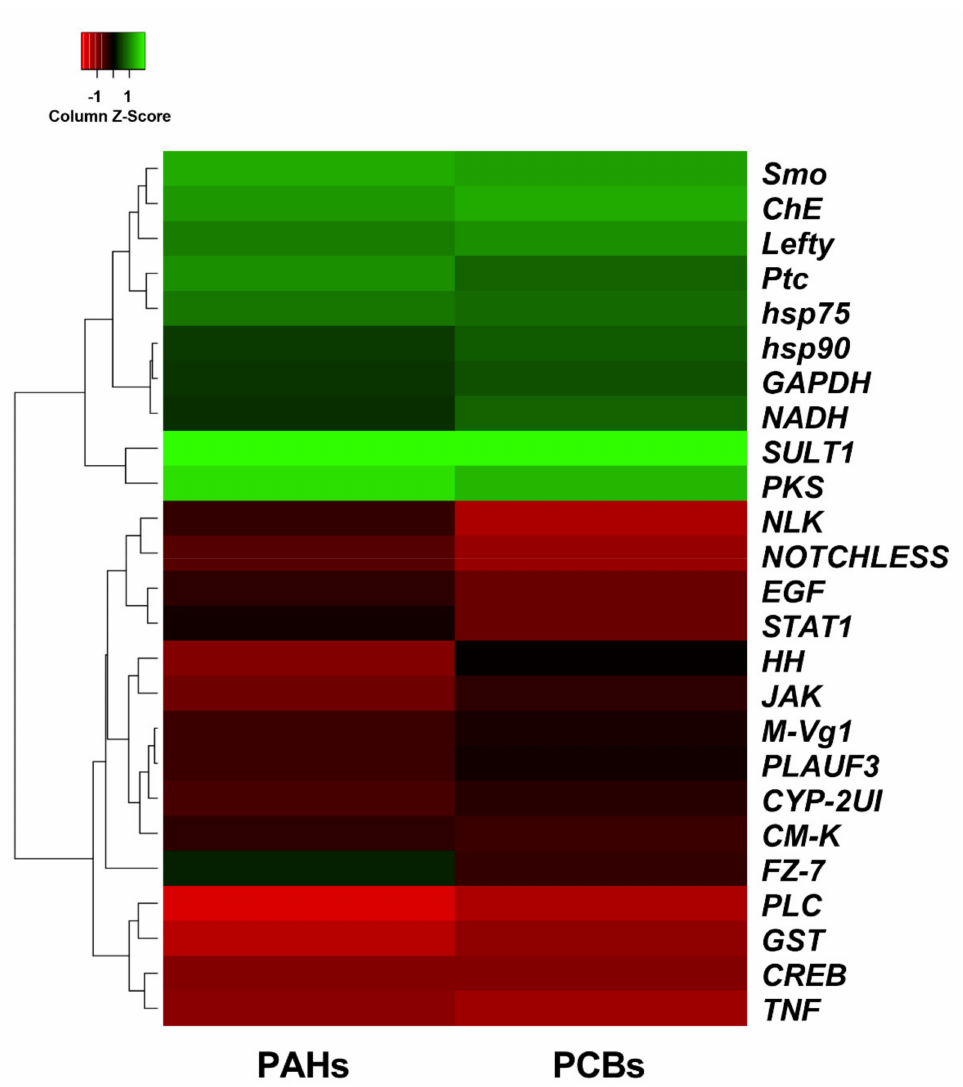
Figure 4. Heatmap showing the expression profiles and hierarchical clustering of 25 genes analyzed by Real Time qPCR in embryos deriving from adult P. lividus sea urchins exposed for 2 months to sediment contaminated with PAHs and PCBs. Color code: green, up-regulated genes with respect to the control; red, down-regulated genes with respect to the control; black, genes for which there is no variation in gene expression with respect to the